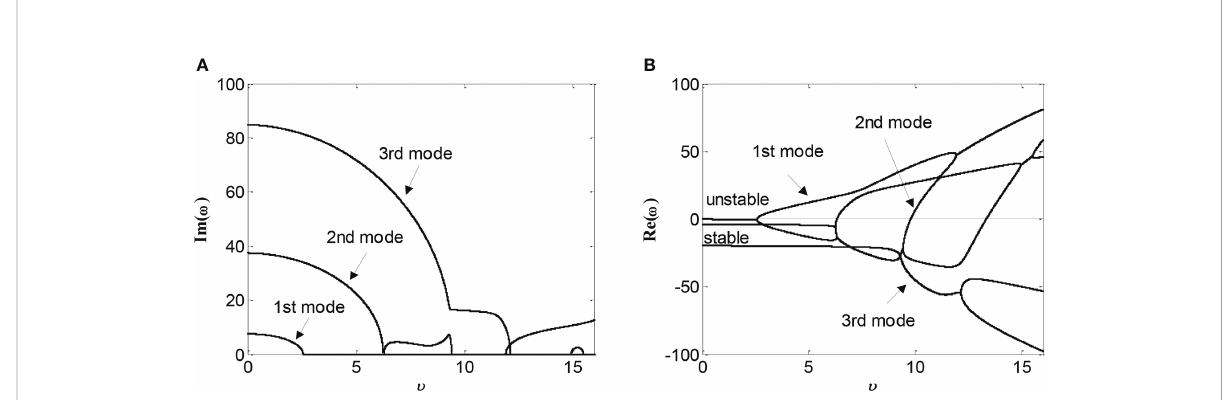
FIGURE 6 Variations of the non-dimensional frequency w with the moving speed υ , for the fi rst three modes of pinned-pinned pipe with internal fl uid velocity u = 2: (A) the imaginary parts; (B) the real